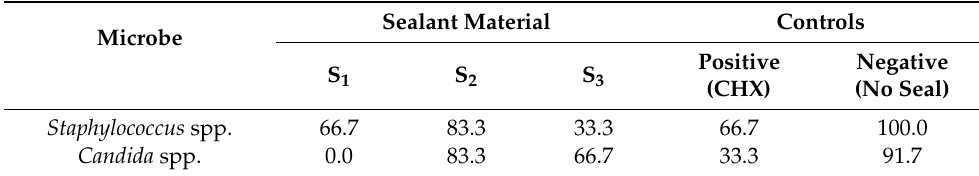
Table 1. Percentage of implant–abutment assemblies that became infected in each group ( n = 6 in each group). Microbe